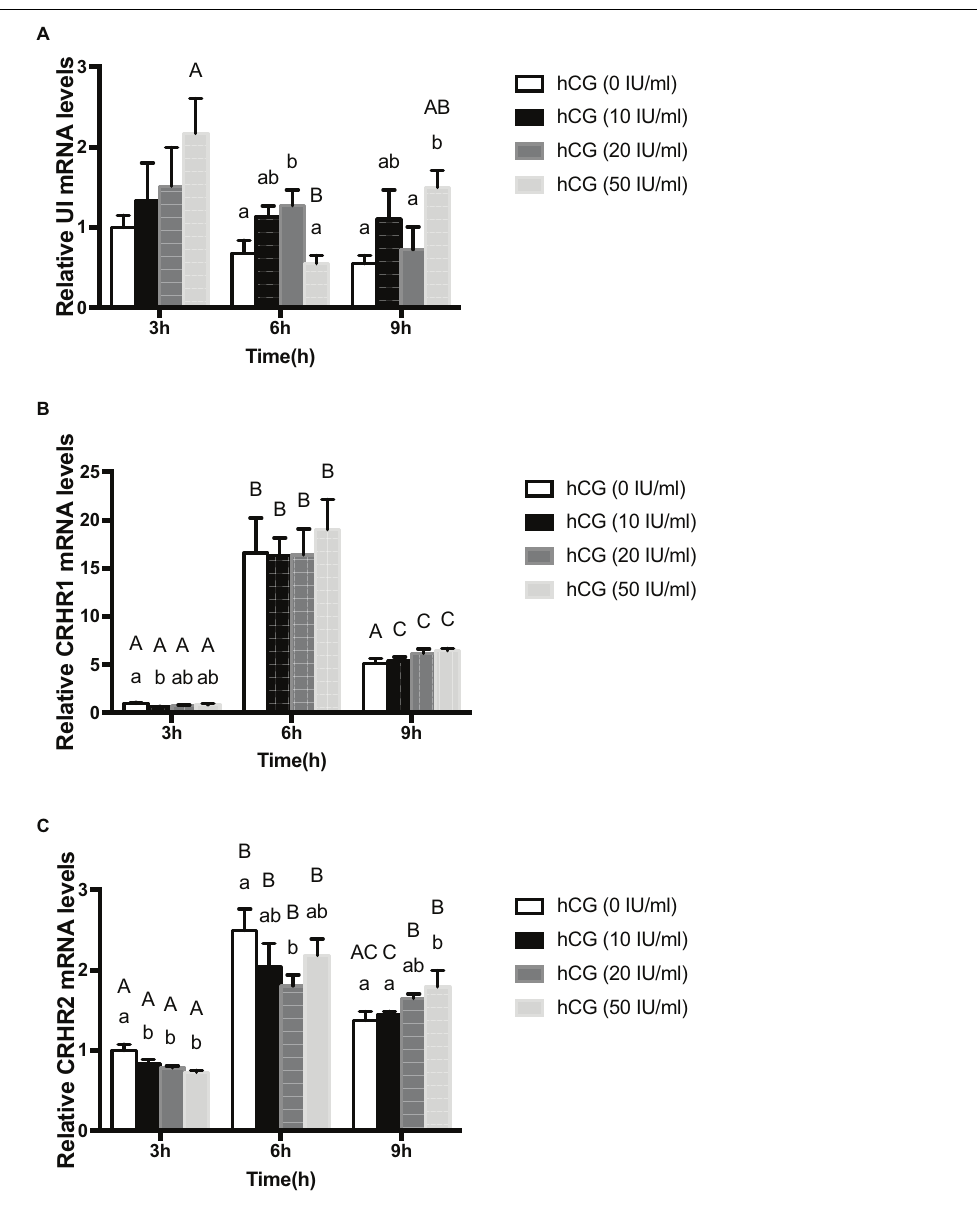
FIGURE 5 | The change of expression level of UI (A) , CRHR1 (B) , and CRHR2 (C) mRNA in the stage IV follicles regulated by gonadotropin (hCG) in vitro . Data were presented as the fold change relative to hCG (0 IU/ml), which was arbitrarily set at 1. Values are means ± SEM, n = 6 per group. Different lowercase indicates statistical significance ( P < 0.05) in concentration-dependent manner and different capital indicate statistical significance in time-dependent manner ( P <